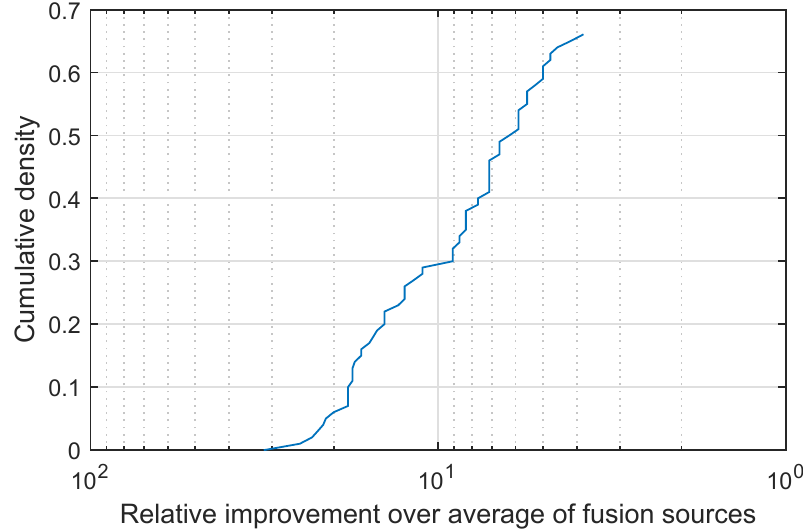
Figure 4. General object recognition: relative improvement in the correct information source identification of the proposed quadratic mean-based fusion over linear fusion, as the corresponding cumulative distribution function.